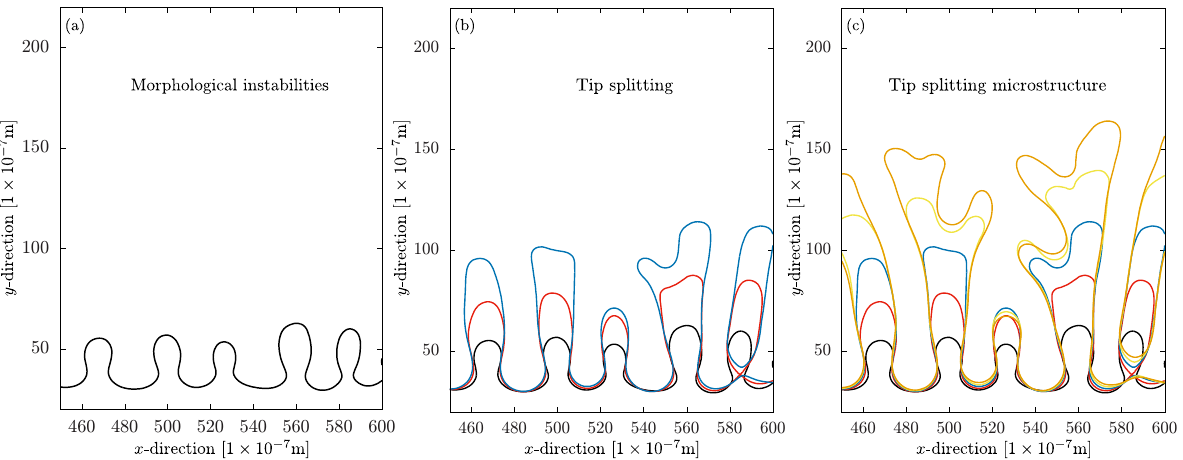
Figure 2. ( a – c ) Phase-field isolines illustrating the development of a tip-splitting microstructure from a unidirectionally solidified solid–liquid interface. Morphological instabilities evolve with time to undergo successive branching at the tip. Sequential steps to generate a seaweed microstructure: Initial morphological instabilities amplification of tips tip-splitting event. Isolines with various → → colors represent different simulation